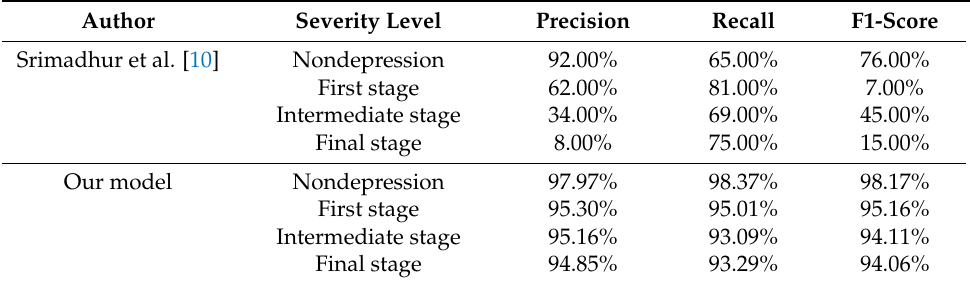
Table 14. Comparison of the classification accuracy between our model and the existing methods in the four-class classification under Setting